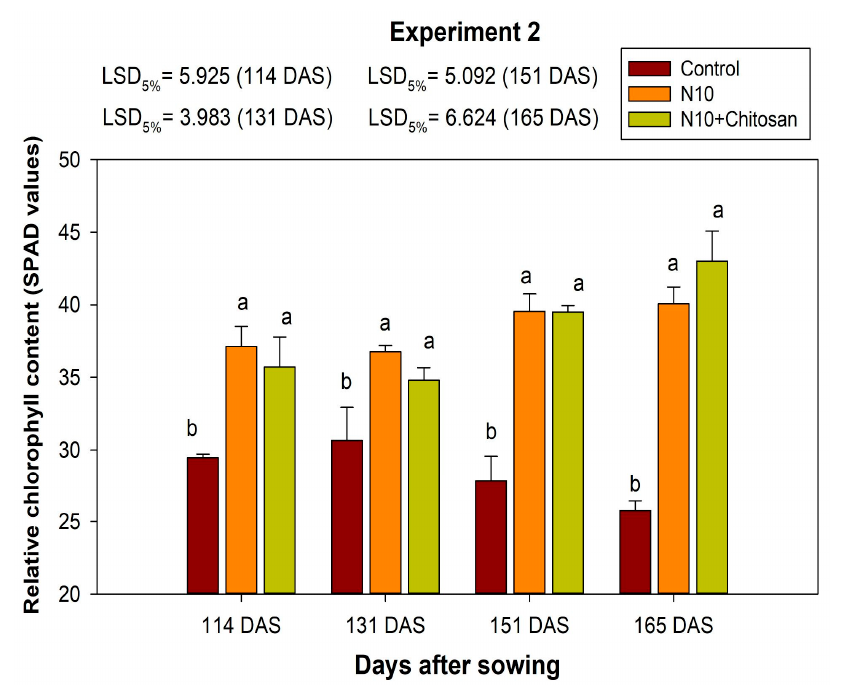
Figure 5. Relative chlorophyll content (SPAD values) of bristly oxtongue as affected by nitrogen fertilization and chitosan application. For each sampling date, bars followed by the same letters were not shown to significantly differ with Fisher’s least significant difference (LSD) test. The error bars show the Standard Error values. Final measurement (source of variation: treatments): Fvalue = 29.872, p = 0.004, DF (degrees of freedom) = 2.